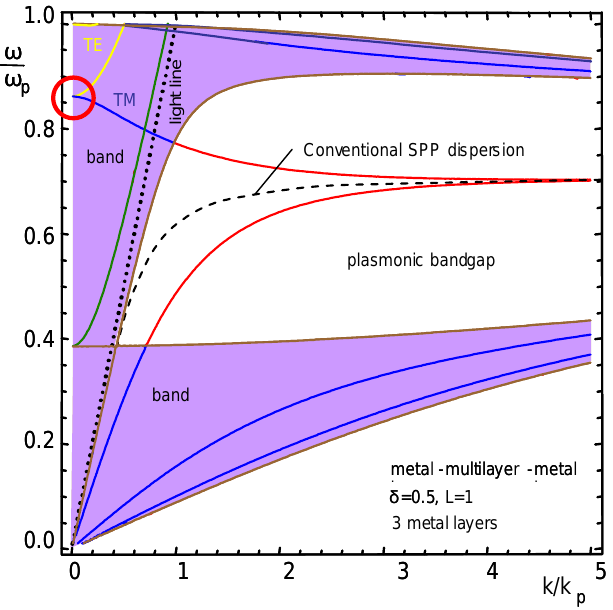
Figure 5. Dispersion of guided modes for N = 3, Drude metal on both sides of the nanomembrane multilayer (exact